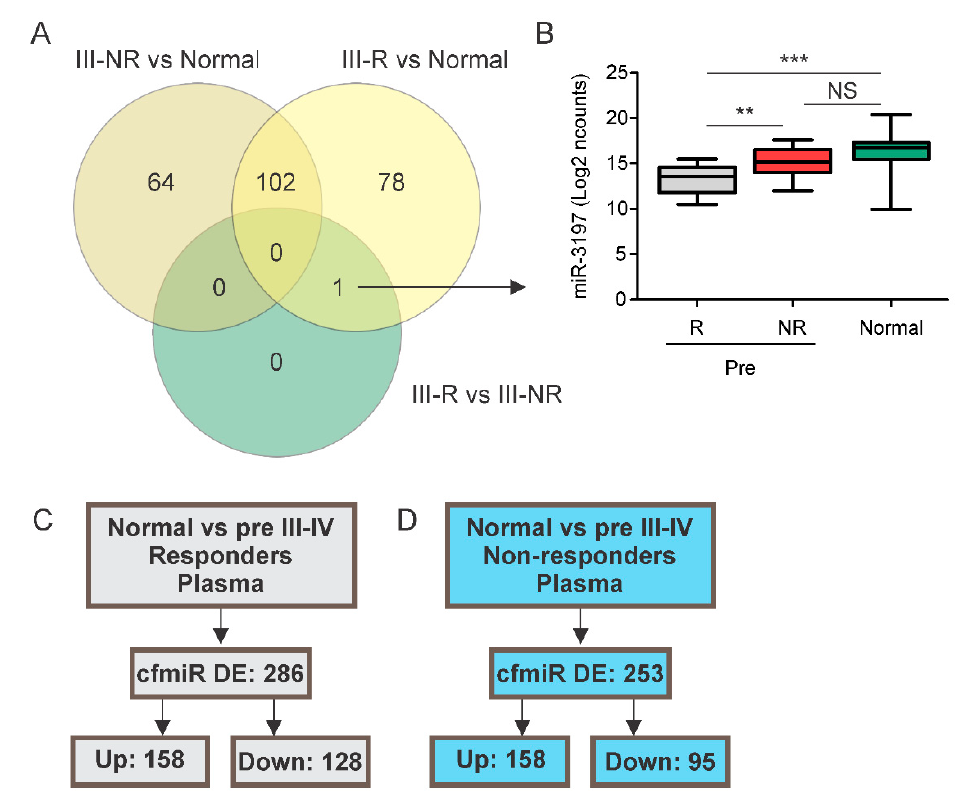
Figure 4. Characterization of cfmiRs in stage III melanoma patients. ( A ) Venn diagram showing the number of cfmiRs found in each comparison: stage III non-responders versus normal donors (III-NR vs. N); stage III responders versus normal donors (III-R vs. N); stage III responders versus non-responders (III-R vs. III-NR). ( B ) Boxplot showing the levels of miR-3197 in stage III responders (R), non-responders (NR), and normal donors’ plasma samples. (** p < 0.01, *** p < 0.001, NS, non-significant). ( C ) Shown are the DE cfmiRs in normal donors’ versus pre-treatment plasma samples from stage III/IV responder melanoma patients. ( D ) Shown are the DE cfmiRs in normal donors versus pre-treatment plasma samples in stage III/IV non-responders melanoma patients.